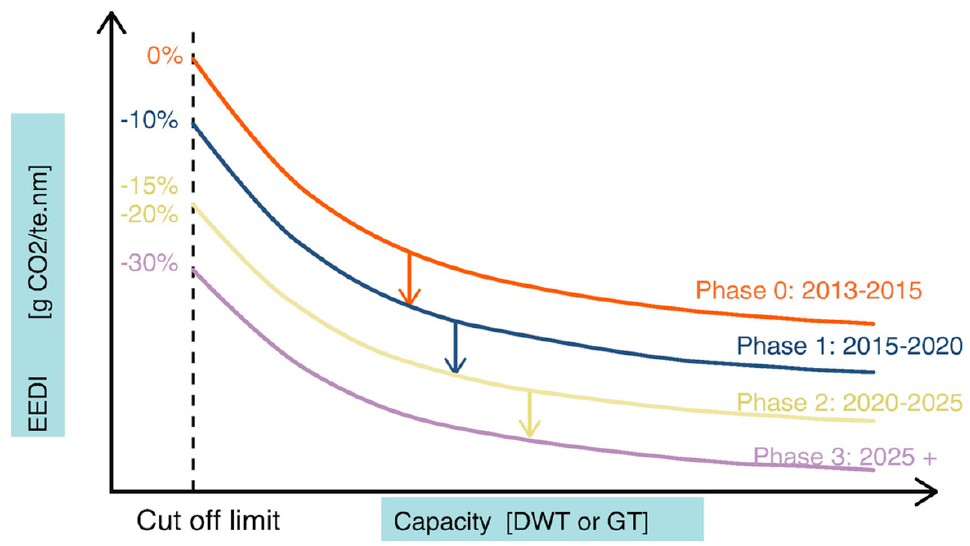
Figure 1. Phases for reduction factors of EEDI [4].